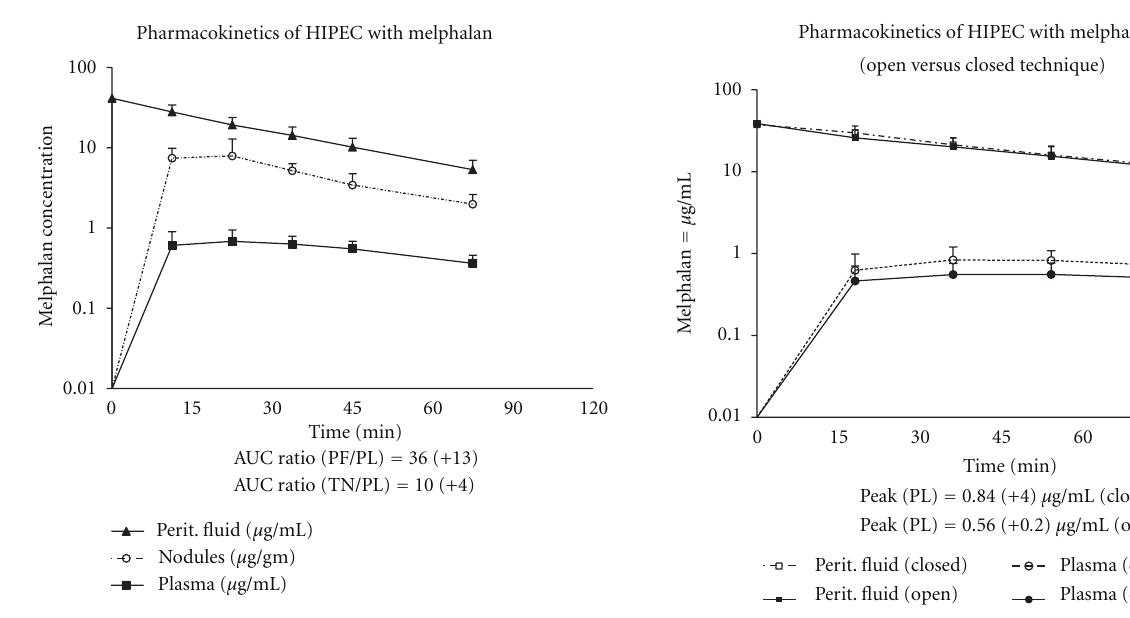
Figure 4: Pharmacokinetics of hyperthermic intraperitoneal mel- phalan in 3 patients in whom the closed technique was used com- pared to 12 patients treated with the open technique. The di ff erence in the plasma levels was not statistically significant ( P = 0 .